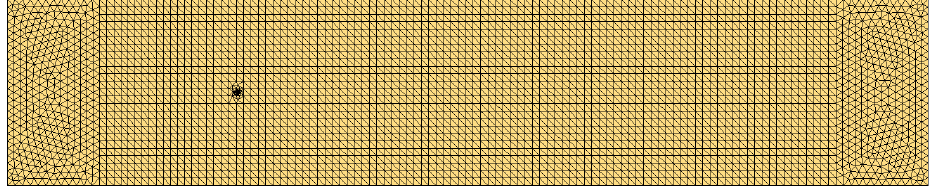
Figure 2. Finite element mesh used for case A in Figure 1. Table 2. Fill times and injectability numbers for injection cases through a point inlet.